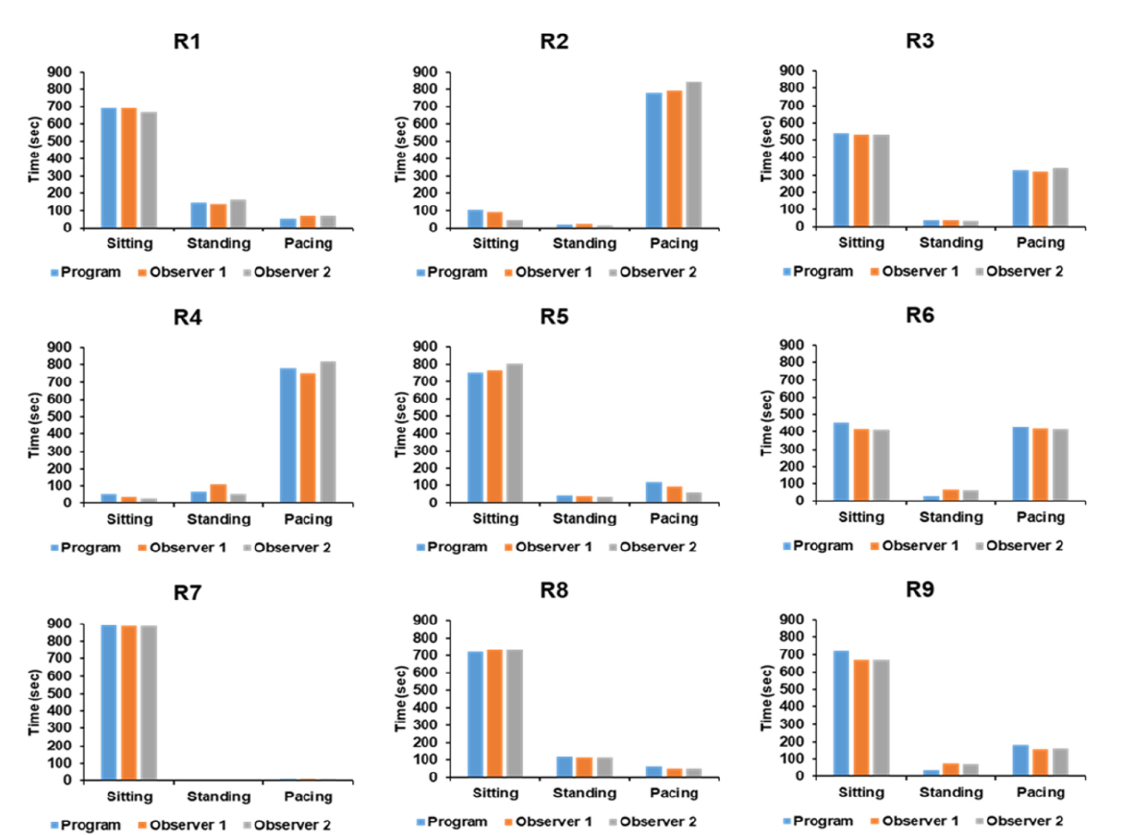
Figure 7. Comparison of measurement analysis from the automated program against two observers for each